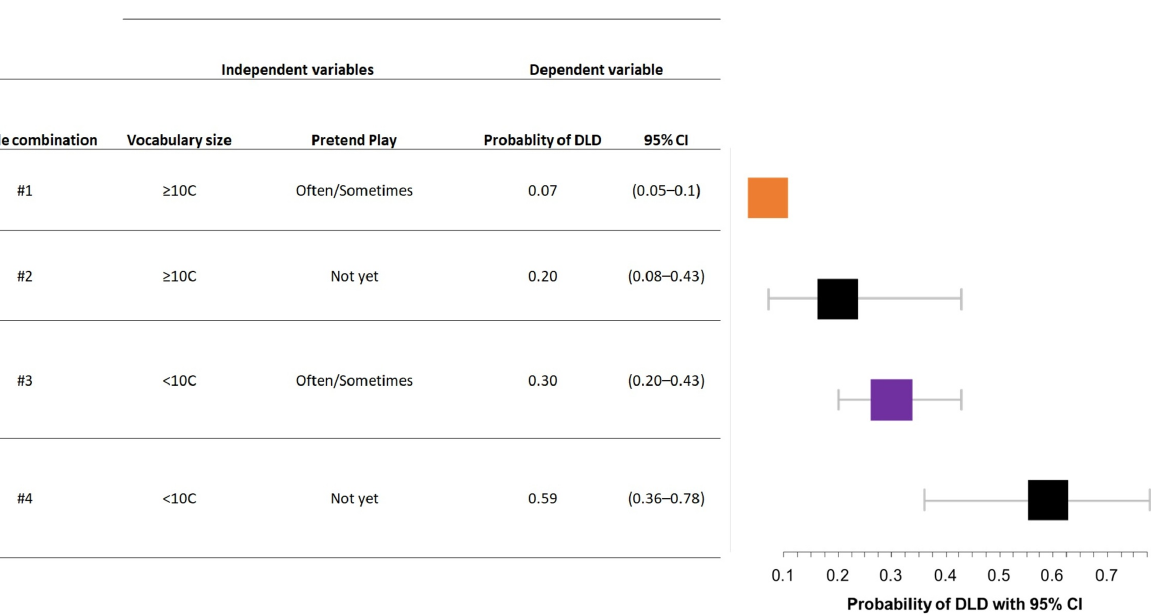
Figure 3. Probability of receiving a diagnosis of DLD associated with the possible combinations among the different levels of the variables entered in the best multivariable model.